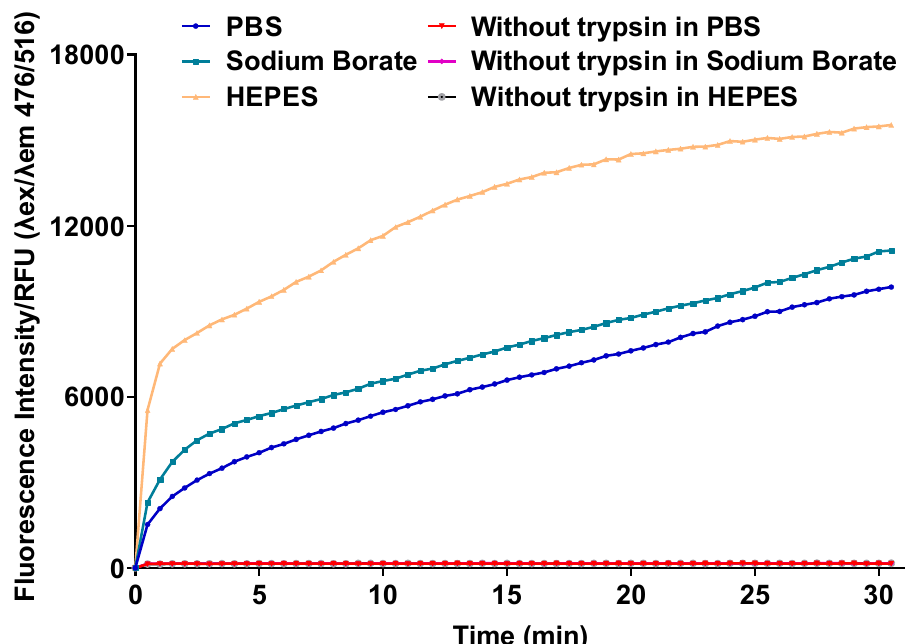
Figure 3. Selection of an optimum buffer for the highest proteolytic activity of trypsin on a peptide substrate. Trypsin activity was measured with fluorescence emission by the reaction of 1 µ M MeRho- Lys-Gly-Leu(Ac) peptide substrate with trypsin (2 µ g/mL) during 30 min in different buffer